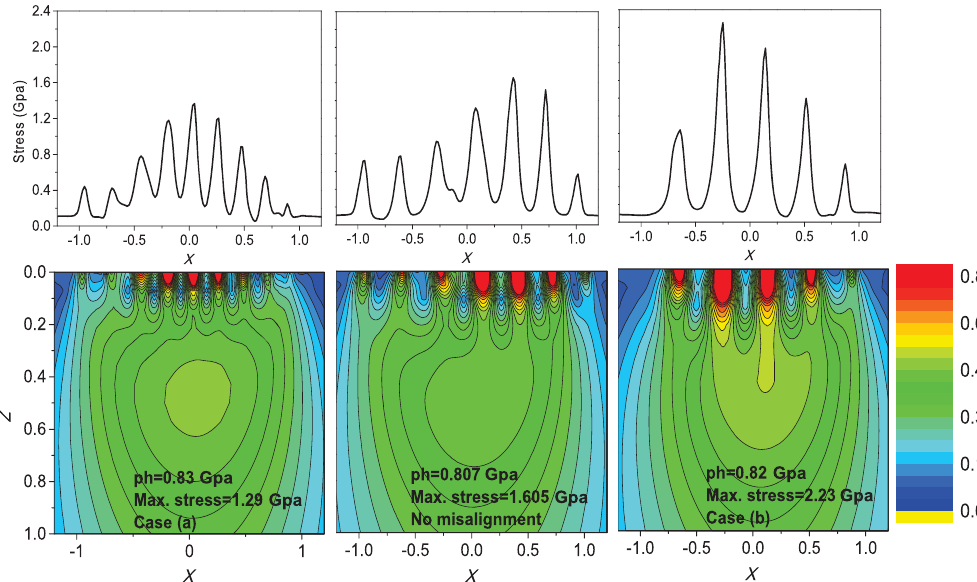
Fig. 18 Octahedral stress at the meshing-in point for Case (a), no misalignment, and Case